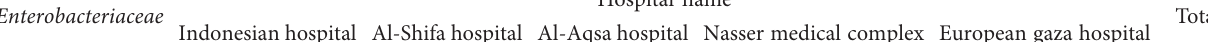
Table 1: Enterobacteriaceae recovered from clinical specimen distribution by